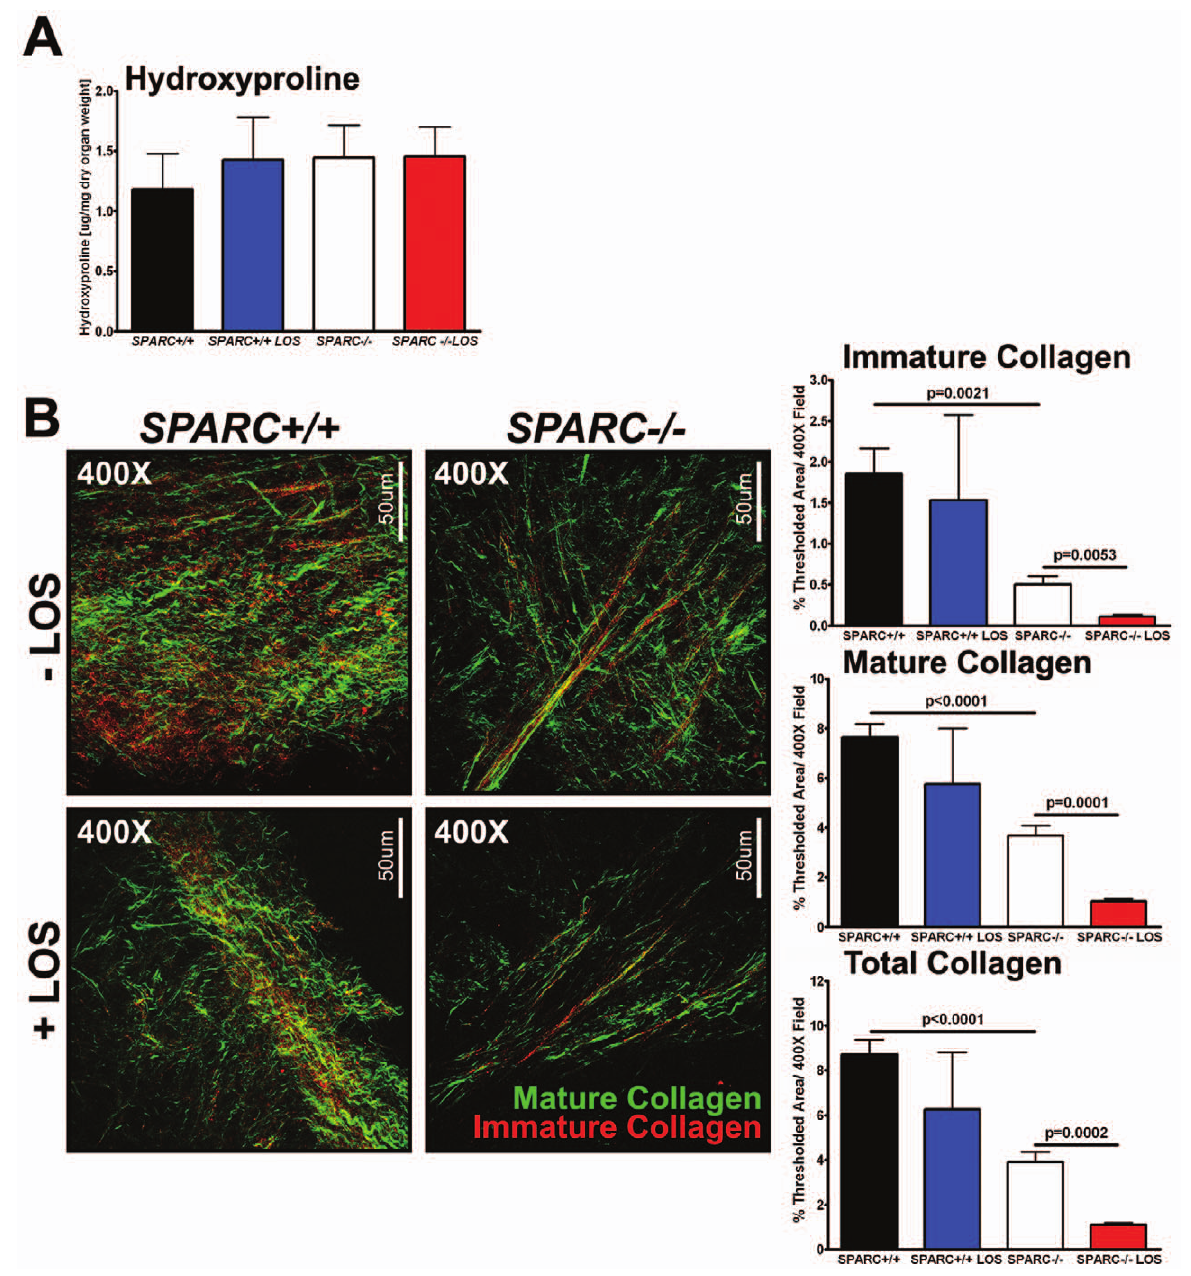
Figure 5. Losartan effect on collagen deposition and maturation. The amount of collagen production, deposition and maturation was assessed in Pan02 orthotopic tumors grown in SPARC + / + and SPARC 2 / 2 mice treated with losartan. (A) The amount of collagen produced and secreted within tumors was quantified by hydroxyproline analysis. (B) Collagen content and maturity was quantified by second harmonic generation (SHG). Frozen tumor sections (50 m m) were mounted in PBS. Collagen fibers within the tumor sections were excited at 900 nm to generate a SHG signal which was then detected at 450 nm. Both forward scattered signal, indicative of mature collagen (green) and backward scattered signal, indicative of immature collagen (red) was detected. Percent thresholded area of immature, mature and total collagen was quantified. Total magnification (400 6 ) and scale bars (50 m m) are indicated. All p-values were calculated with the Student’s t test.